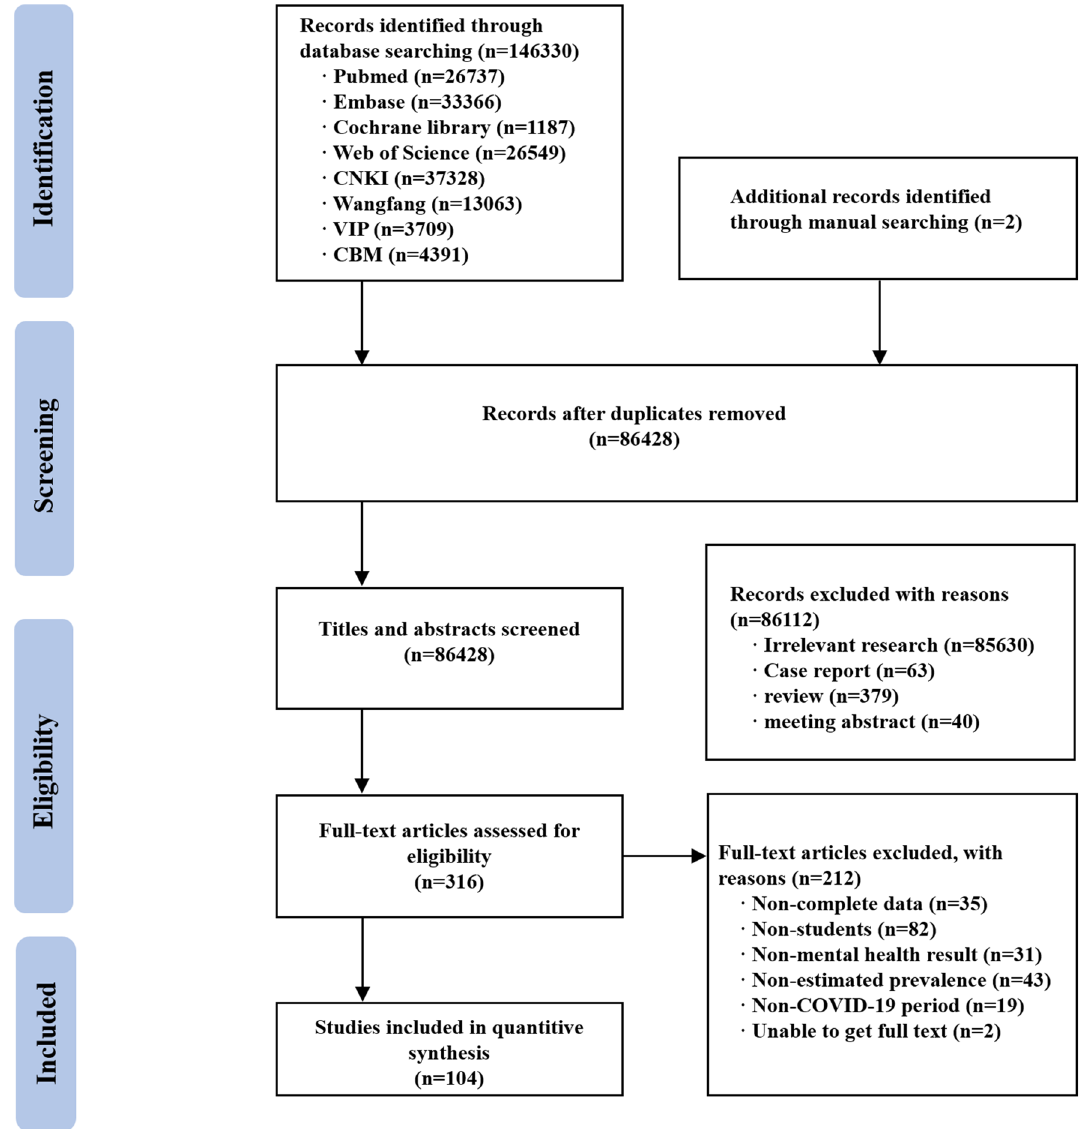
Figure 1. Flow diagram of the progress of acquiring the qualified literature and studies included in the meta-